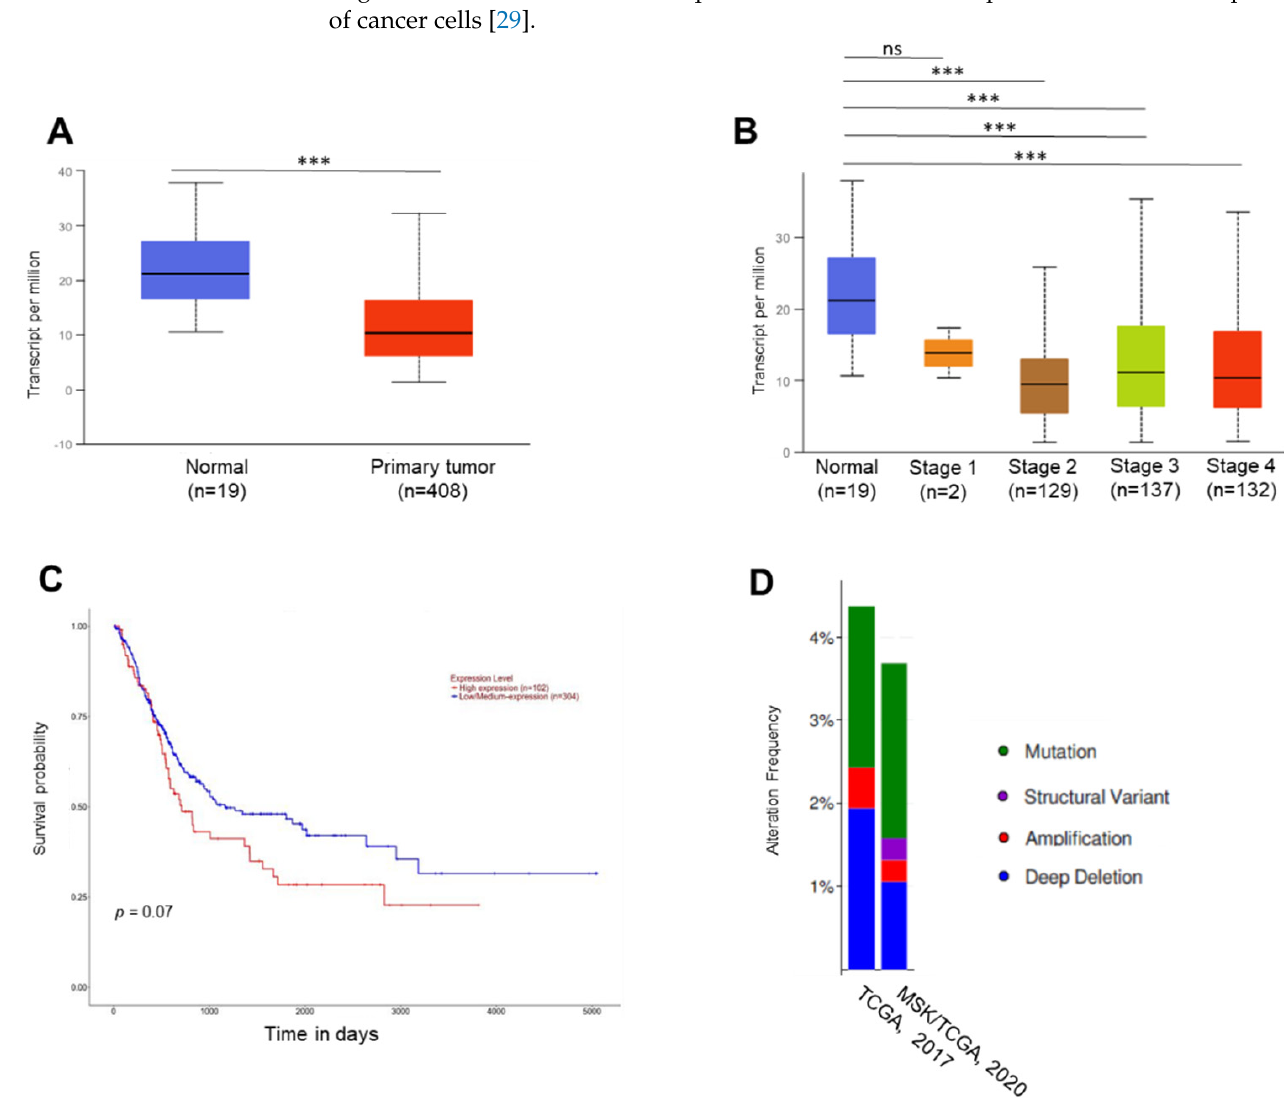
Figure 1. TKS5 expression and genetic alterations in bladder cancer samples. We based the in silico analyses on the TCGA sequencing results. We generated graphs A, B and C and the statistical significances via the UALCAN data analysis portal [39,40]. The numbers in parentheses indicate the numbers of patients in the respective groups. We generated graph D via the cBioPortal [41,42]. ( A ) Expression of TKS5 in normal bladder tissues (n = 19) and primary bladder tumour samples (n = 408). We indicate the mRNA levels as transcripts per million. ( B ) Expression of TKS5 in normal bladder tissues and BC tissues based on individual cancer states. ( C ) Survival probability of bladder cancer patients in correlation with TKS5 mRNA levels. ( D ) TKS5 alteration frequency in patients with primary bladder cancer in two different urothelial cancer studies. *** p <